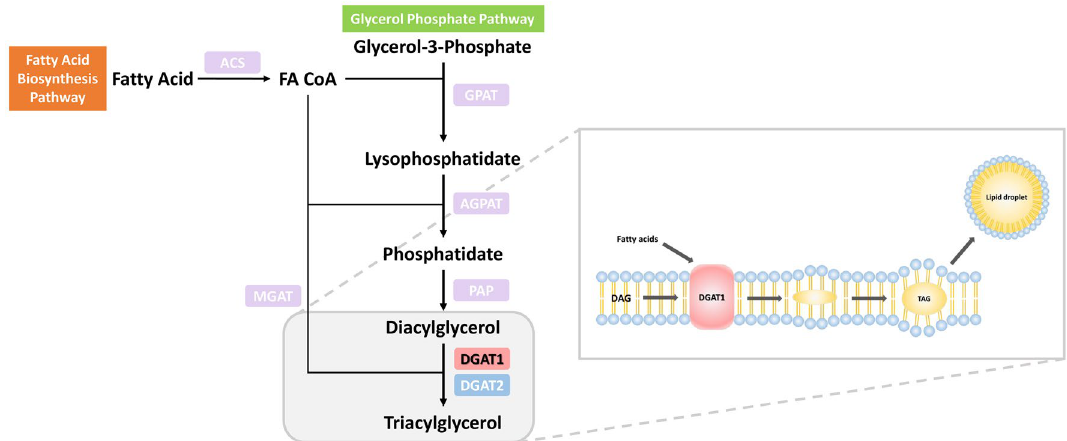
Figure 1. Schematic pathway of triacylglycerol biosynthesis. It illustrates the role of DGAT1 in triacylglycerol synthesis that is responsible for fat content in the milk.